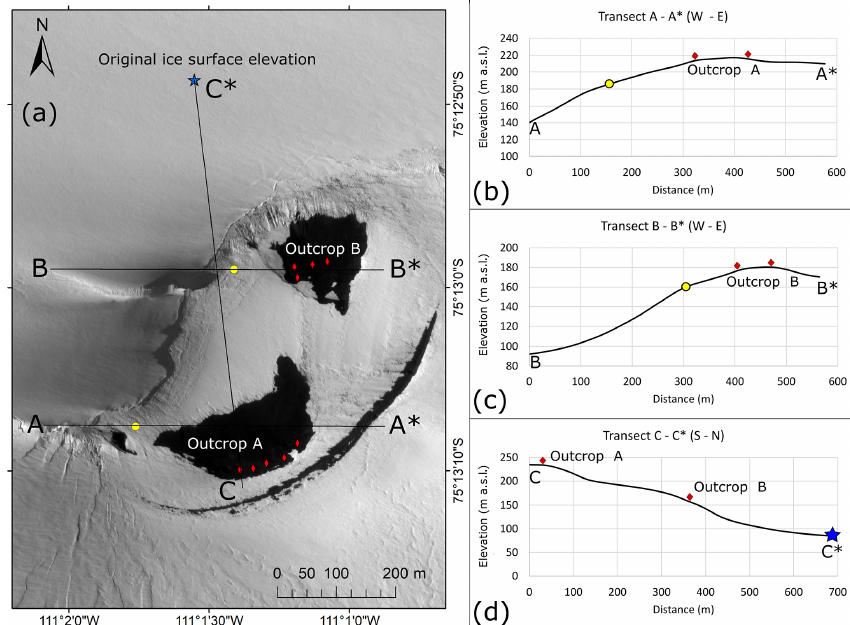
Figure C1. Transects displaying topographic profiles of the scoria cone and ice surface elevations adjacent to the Pope Glacier. (a) Map showing scoria cone outcrops A and B adjacent to the Pope Glacier, sample locations and location of topographic profiles along transects A– A*, B–B* and C–C*. Location of original representative reference modern ice surface elevation (blue star) at 80ma.s.l. was measured from a Mt. Murphy digital elevation model (DEM). Outcrop-specific ice surface elevations (yellow circles) used to calculate vertical distances above the ice surface relative to outcrop A and outcrop B were input for the sensitivity test of the linear regression analyses. Red diamonds indicate the position of scoria cone samples. (b) Topographic profile along transects A–A* for outcrop A with outcrop-specific ice surface elevation (yellow circle at 183ma.s.l.) and sample positions adjacent to transect. (c) Topographic profile along transects B–B* for outcrop B with outcrop-specific ice surface elevation (yellow circle at 159ma.s.l.) and sample positions adjacent to transect. (d) Transect C–C* showing to- pographic profile extending S–N from scoria cone outcrop A to the original representative ice surface elevation at − 75 . 21352 ◦ , − 111 . 02586 ◦ that was used to calculate the vertical distance above the modern ice surface in our preferred model for ice surface thinning rate and timing (main paper, Fig. 6b). For transect C–C*, one representative sample elevation each is shown for outcrop A and outcrop B. Note some sample locations ( n = 12) are undifferentiated on the map and transects due to their close proximity.